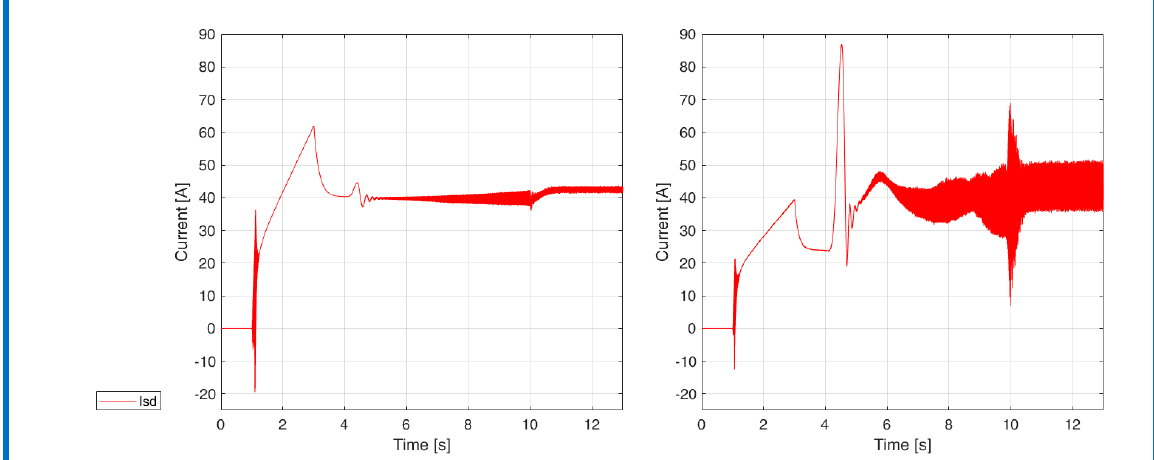
Figure 14. Stator current d-axis with ideal generators (left) and with inverter (right).